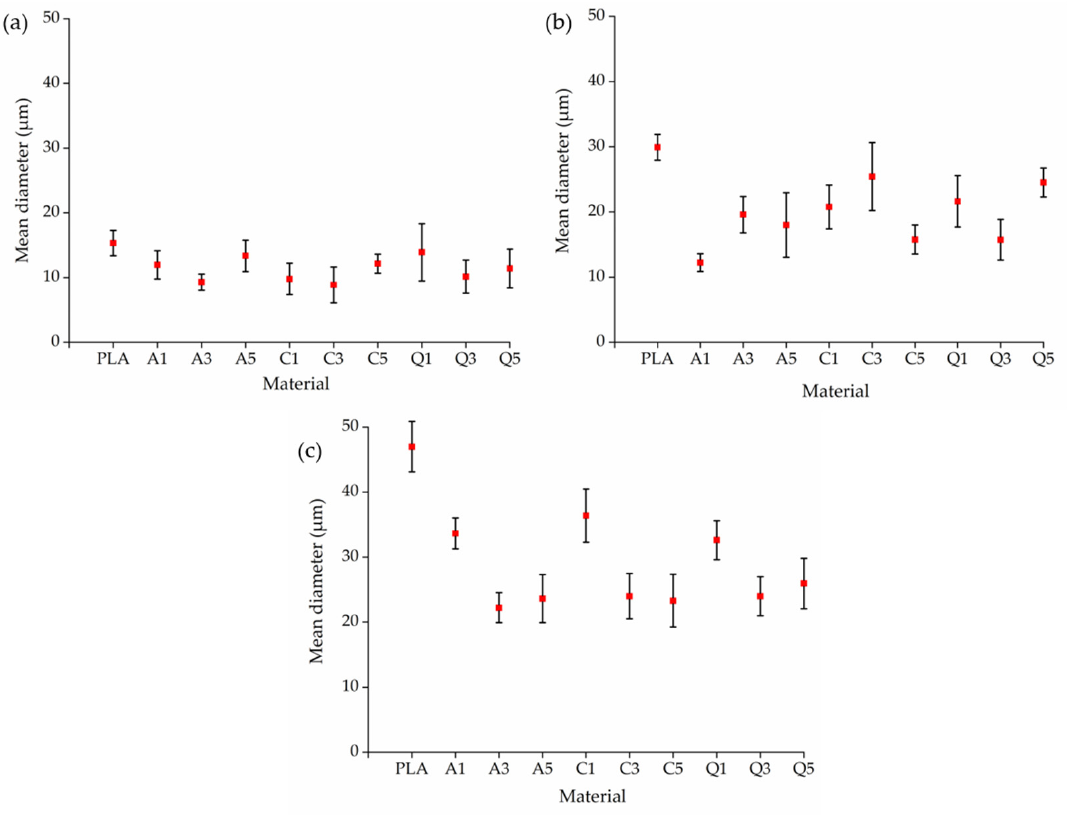
Figure 18. Mean diameters of fibers prepared from pure PLA and composites containing 1%, 3%, or 5% ( w / w ) of alizarin (A1, A3, A5), curcumin (C1, C3, C5), or quercetin (Q1, Q3, Q5) at pump speeds of ( a ) 2 rpm, ( b ) 5 rpm, and ( c ) 10 rpm.